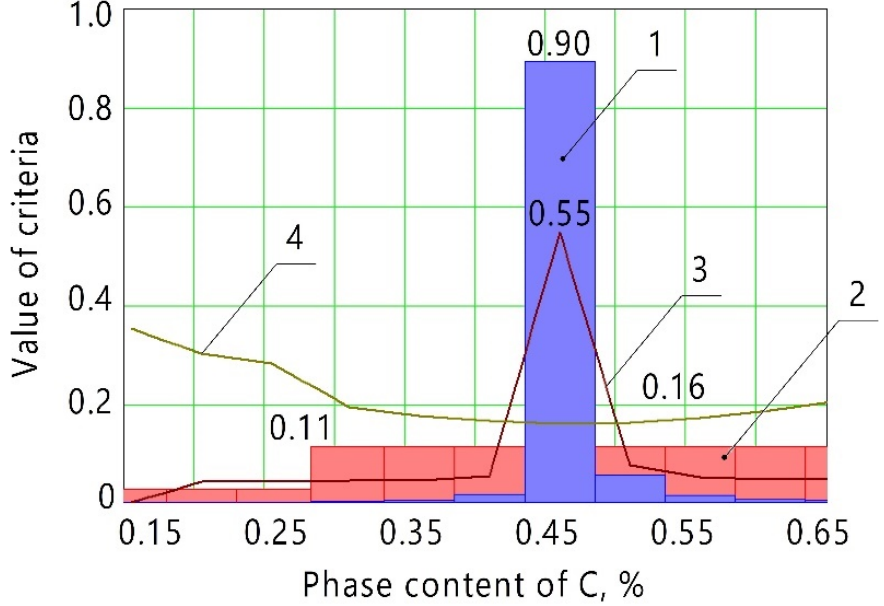
Figure 3. Graphical representation of the decision-making approach for material selection: 1—the normalized similarity criteria for C; 2—the normalized similarity criteria for Mn; 3—the overall normalized similarity criterion; 4—root mean square.